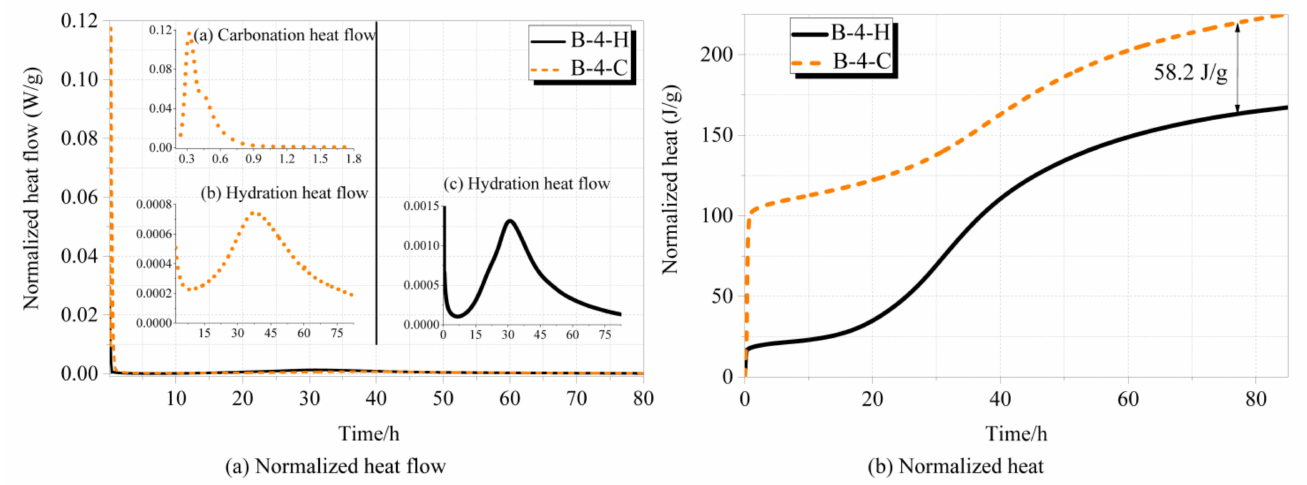
Figure 11. Normalized carbonation–hydration heat flow ( a ) and normalized heat ( b ) of B-4